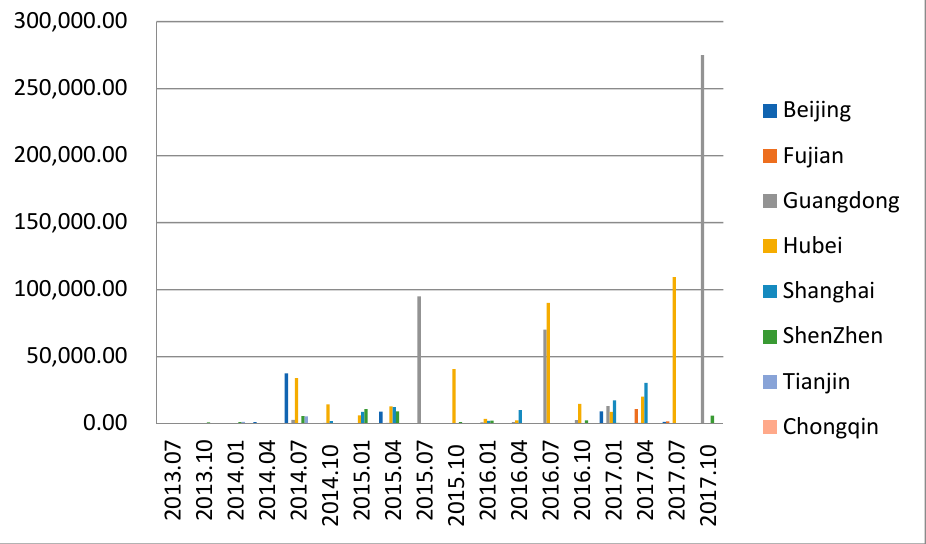
Figure 3. Distribution of carbon trading volume and carbon trading market shares for each pilot [55]. After measuring the status of carbon market trading and the industrial structures of the pilot areas, China has selected the pilot project in Hubei to build the national carbon finance centre because it has brisk market trading [56] and the characteristics of its economic development and industrial structure are the most similar to those of the overall situation of the country [19]. However, the pace of development of the carbon finance in various pilot projects is still slow, making the carbon market fall short of sustained development momentum [27]. At present, the carbon finance of China still lacks detailed institutional arrangements, which makes financial supervision of the carbon market more difficult [57], and the government-led carbon finance market still exacerbates the characteristics of the CCM with poor liquidity and unstable carbon quota prices [58]. Sufficient liquidity of market and accuracy of carbon pricing are essential factors to ensure the smooth operation of the carbon market [59].